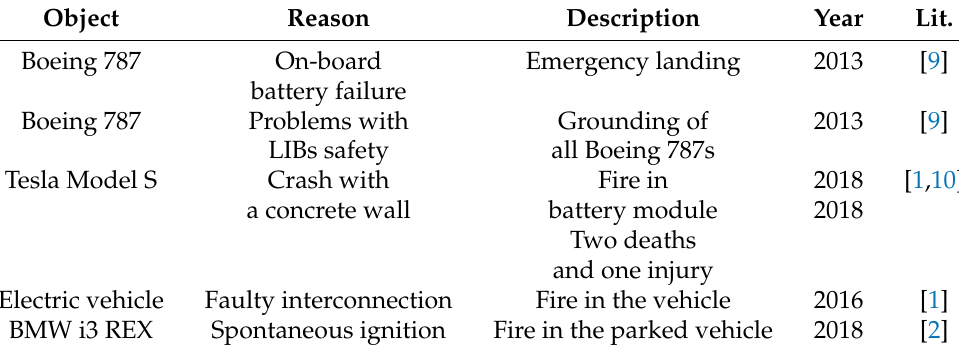
Table 1. Examples of fire accidents in structures with